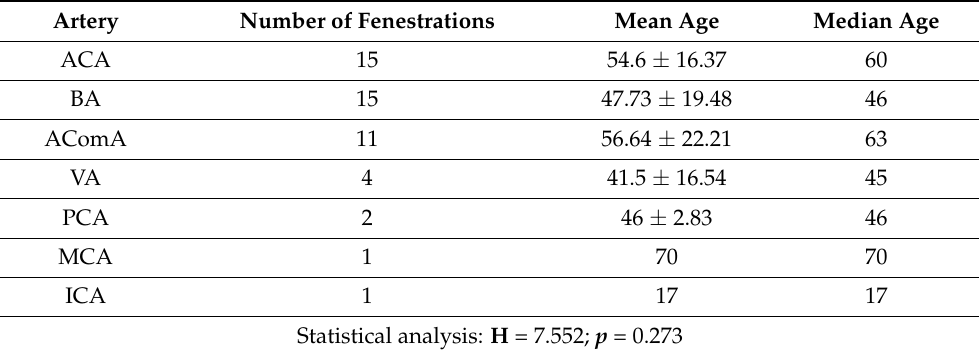
Table 4. Patient age by type of cerebral arterial fenestrations. Artery Number of